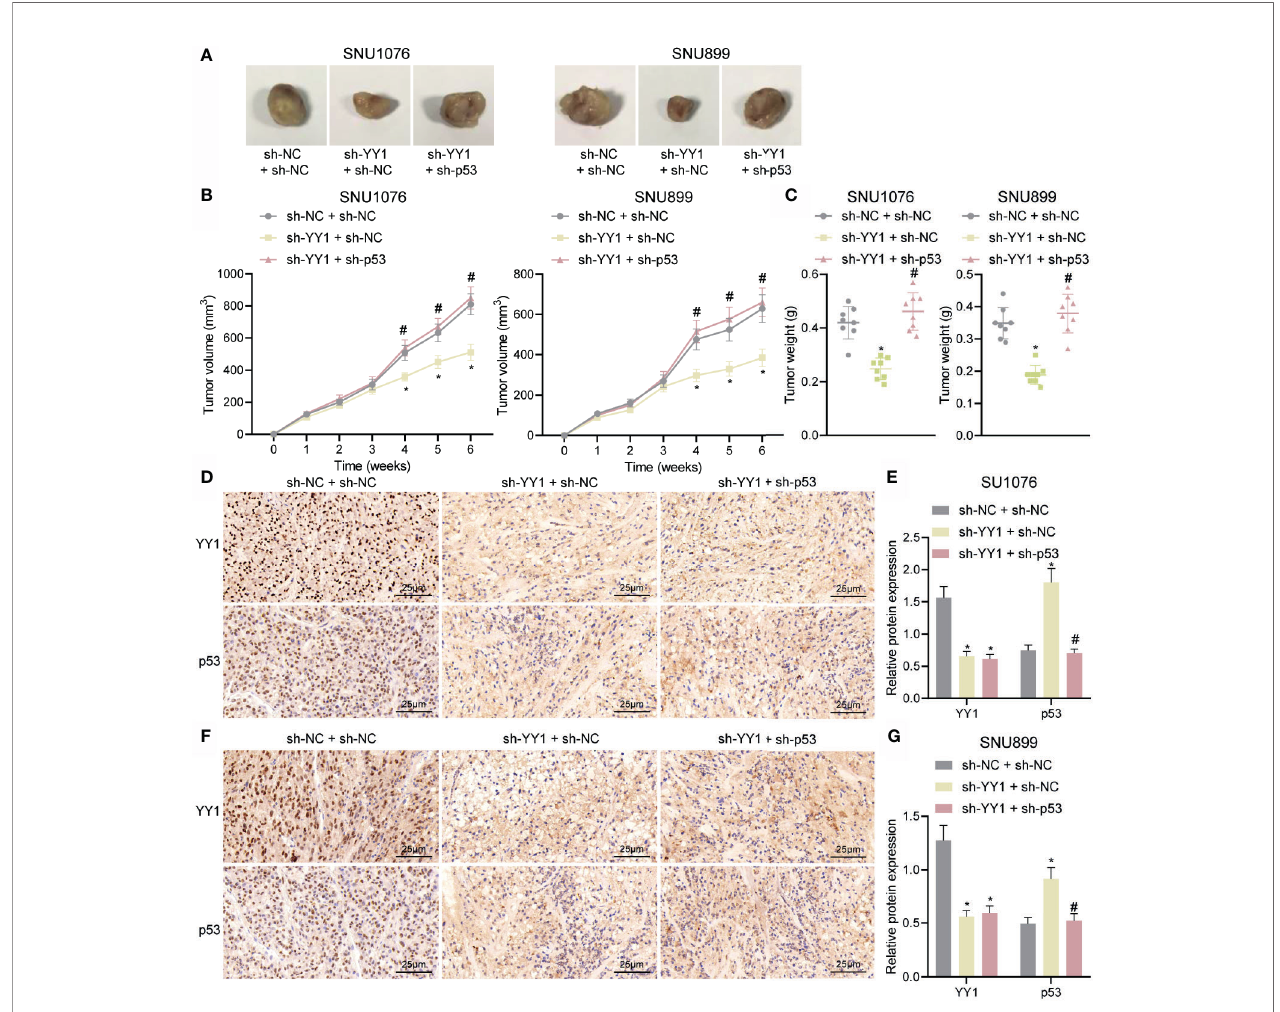
FIGURE 6 | YY1 promotes tumor growth of LSCC via p53 stability suppression in vivo . Mice were injected with SNU1076 and SNU899 cells transfected with sh-YY1 + sh-NC or sh-YY1 + sh-p53. (A) Representative images showing xenografts in nude mice. (B) Tumor volume of mice. (C) Tumor weight of mice. (D) Immunohistochemical staining of YY1 and p53 proteins in tumor tissues of mice injected with SNU1076 cells. (E) Quantitation of panel (D) . (F) Immunohistochemical staining of YY1 and p53 proteins in tumor tissues of mice injected with SNU899 cells. (G) Quantitation of panel (F) * indicates p < 0.05 compared with sh-NC + sh-NC, # indicates p < 0.05 compared with sh-YY1 + sh-NC. Data are shown as mean ± standard deviation of three technical replicates. Data among multiple groups were compared by one-way ANOVA with Tukey ’ s post-hoc tests while those among multiple groups were compared by one-way ANOVA with Tukey ’ s post-hoc tests. Bonferroni-corrected repeated measures ANOVA was applied for data comparison at various time points. n = 8 for mice upon each